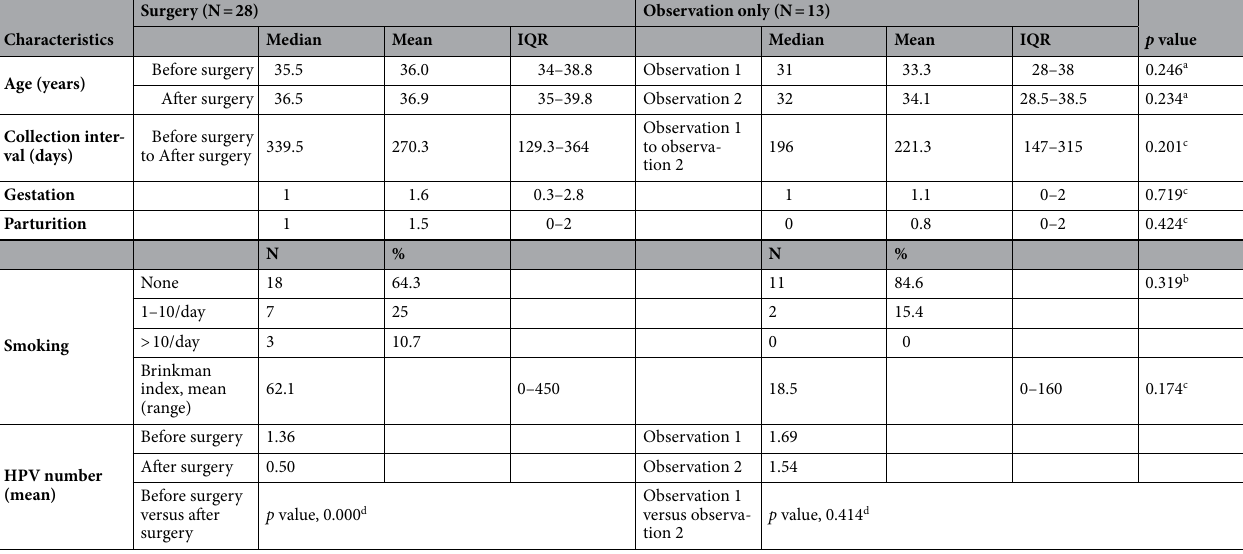
Table 1. Patients’ characteristics. IQR interquartile range. a Independent t-test. b Pearson’s chi-square test. c Mann–Whitney U test. d Wilcoxon signed-rank